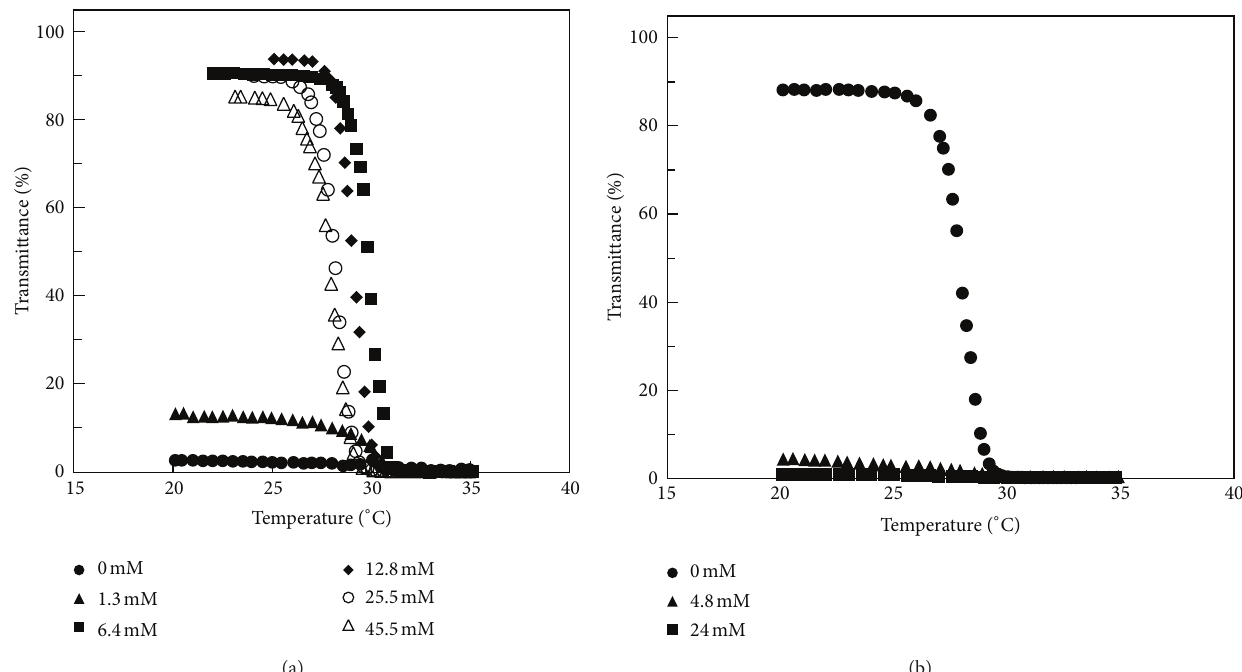
Figure 4: (a) Transmittance change of 10mg/mL solutions of the PNIPAAm- block -PTEMPOMA ( 2 󸀠 ) in 0.1M Na 2 SO 4 aq in the presence of various amounts of L-ascorbic acid 0–45.5 mM and (b) transmittance change of the resulting solutions of the corresponding reduced copolymer in the presence of various amounts of K 3 [Fe(CN) 6